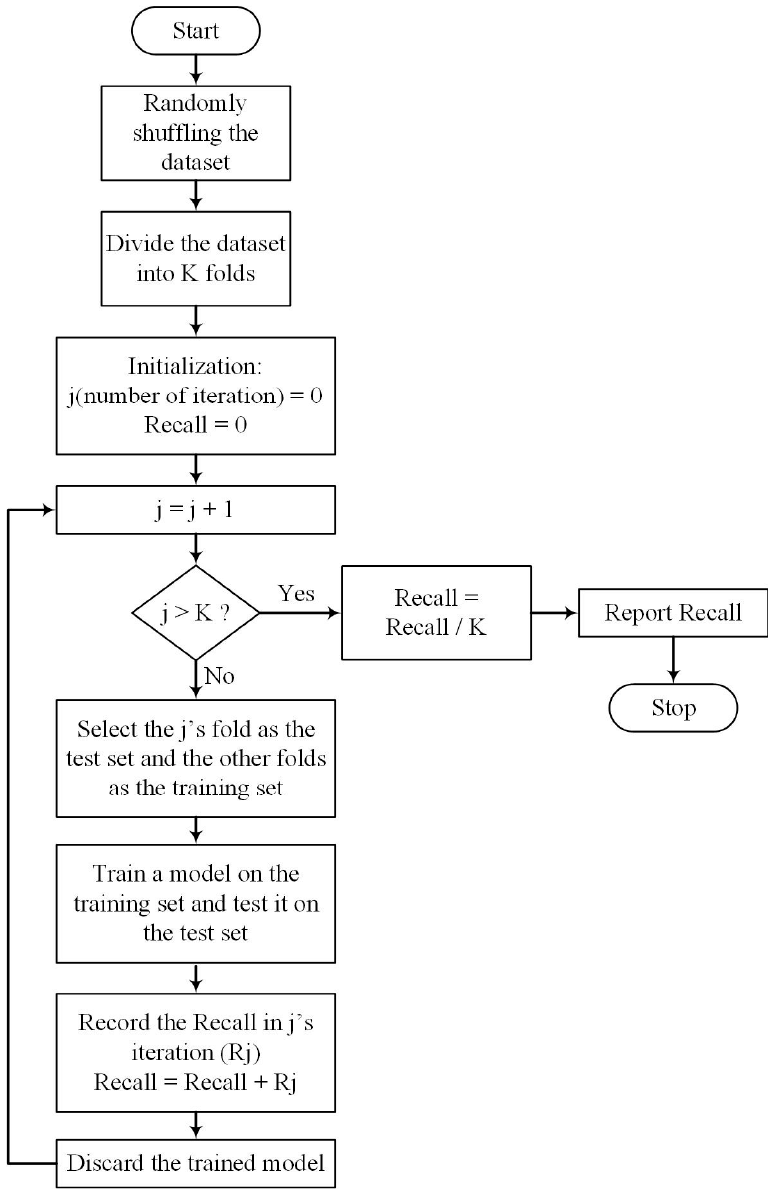
Figure 7. The flowchart of the K-fold cross-validation method.